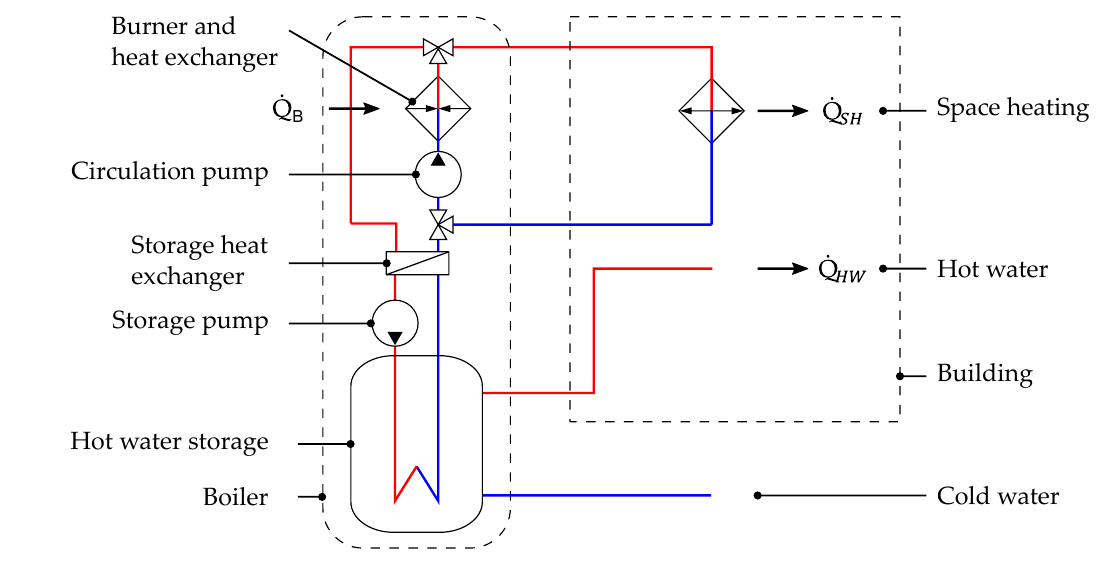
Figure 4. Schematic view of the modeled building energy system. It depicts the analyzed boiler in a typical detached house.